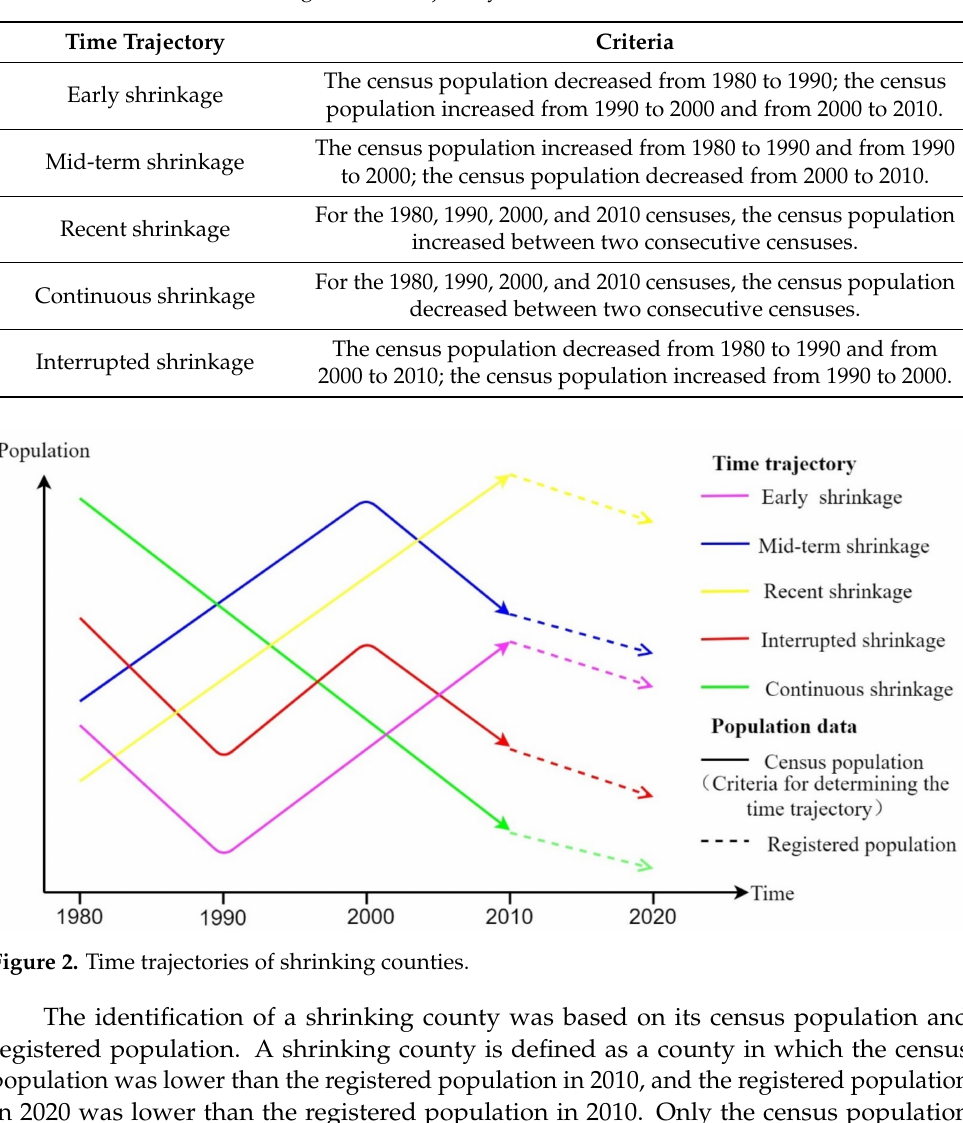
Table 4. Criteria for determining the time trajectory.